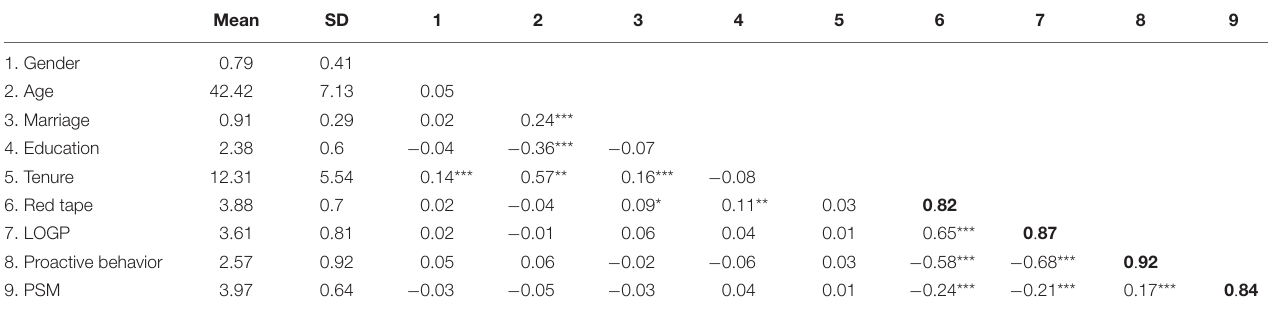
TABLE 3 | Means, standard deviations, and correlations.